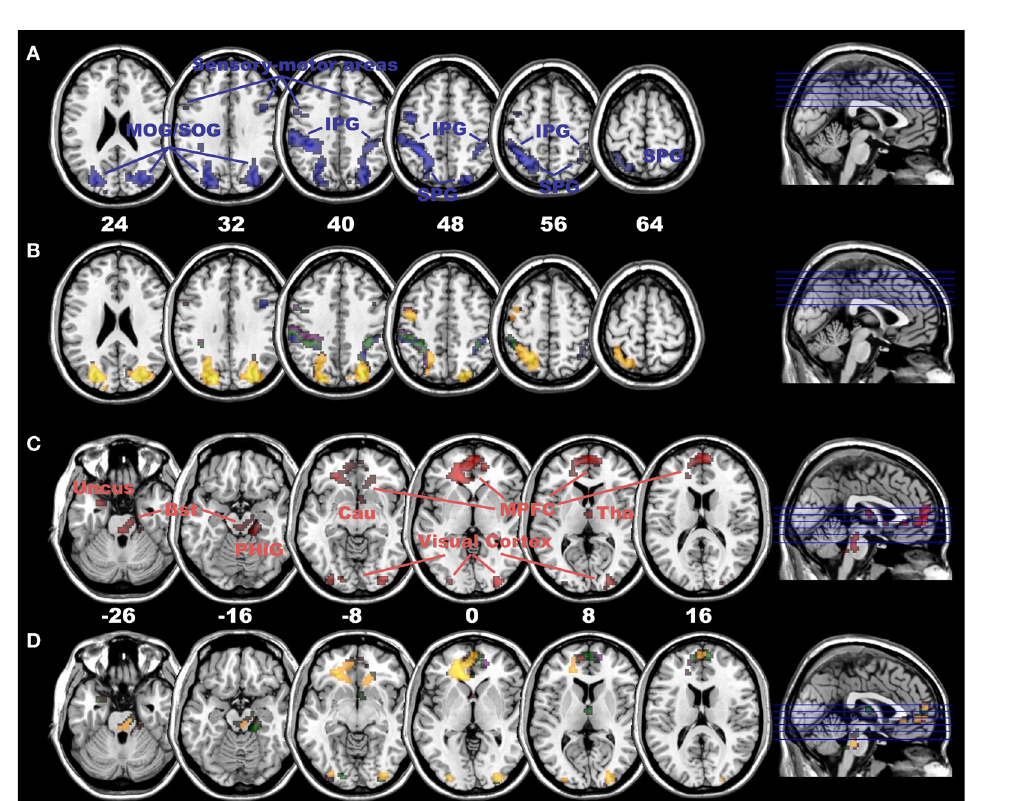
Figure 3 | Negative connectivity with right and positive connectivity with left DLPFC in adults. (A) Negative connectivity (blue colour) with right DLPFC in the dorsal visual stream (including superior and inferior parietal gyrus as well as superior occipital gyrus) and sensory-motor areas in adult subjects (at p < 0.005, cluster extent: 10 voxels; SPG, superior parietal gyrus; IPG, inferior parietal gyrus; MOG, middle occipital gyrus; SOG, superior occipital gyrus). (B) Signifi cant differences in negative connectivity between right DLPFC and left DLPFC in areas depicted in (A) , at p < 0.005 (yellow), p < 0.01 (violet) and p < 0.05 (green, all with a cluster extent of 10 voxels). Most areas, except for the ones in blue colour, depict a clear right-sided lateralization pattern in negative connectivity. (C) Positive connectivity (red colour) with left DLPFC in medial PFC (including ACC), extrastriate visual cortex and subcortical areas (including dorso- medial Thalamus and Brainstem) in adult subjects (at p < 0.005, cluster extent: 10 voxels; MPFC, medial prefrontal cortex; Bst, Brainstem; Tha, Thalamus; Cau, Caudatus; PHiG, Parahippocampal Gyrus). (D) Signifi cant differences in positive connectivity between left DLPFC and right DLPFC in areas depicted in (C) , at p < 0.005 (yellow), p < 0.01 (violet) and p < 0.05 (green, all with a cluster extent of 10 voxels, areas in red colour illustrate no signifi cant difference). All areas, except for a few voxels in the medial PFC in red colour, depict a clear left-sided lateralization pattern in positive connectivity in adult